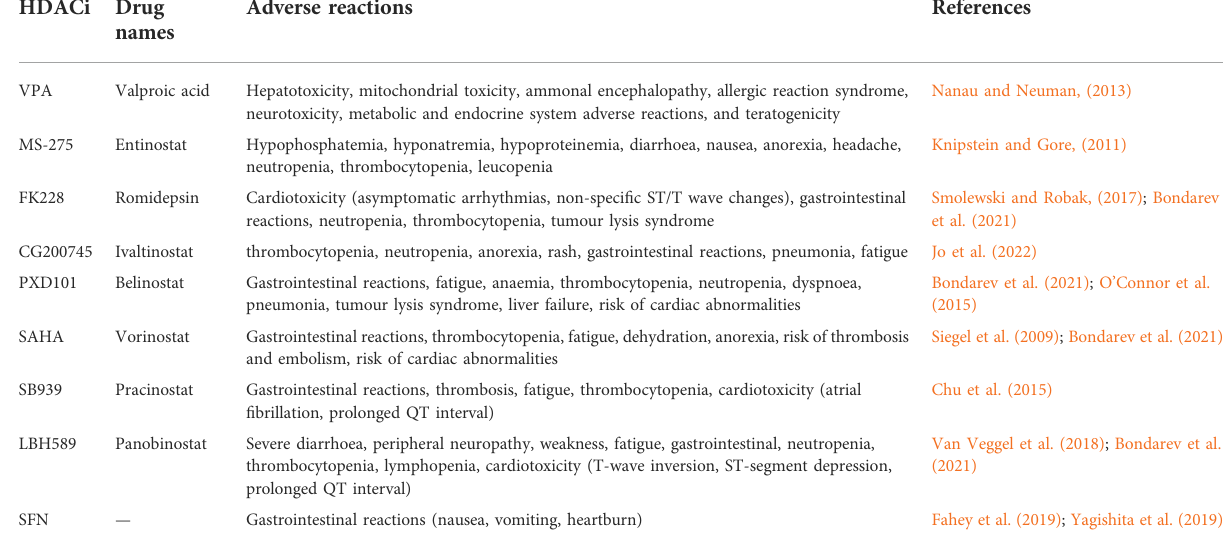
TABLE 4 The adverse reactions of HDAC